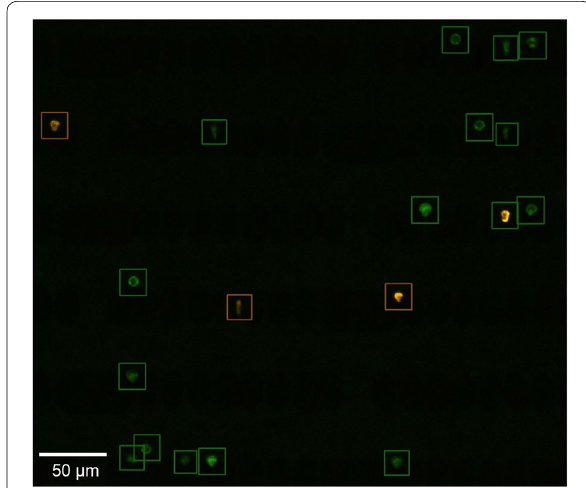
Fig. 6 Results of counting, a part of the image is cropped for better visibility. The detected T-cells were labeled with green rectangle and detected B-cells were labeled with orange